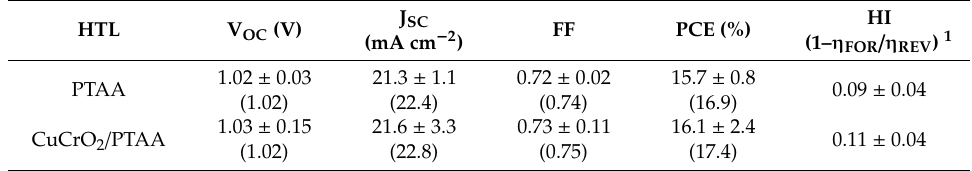
Figure 4. Photovoltaic performances of perovskite solar cells with CuCrO 2 / PTAA or PTAA as HTL: ( a ) J-V curves of champion cells and their steady-state e ffi ciencies under maximum power voltage; ( b ) PCE distributions for 20 cells at each condition; ( c ) External quantum e ffi ciency (EQE) of solar cells. Table 1. Photovoltaic parameters of the solar cells (reverse scan for 20 cells). The data in parentheses are from the cells with the best power conversion e ffi ciency